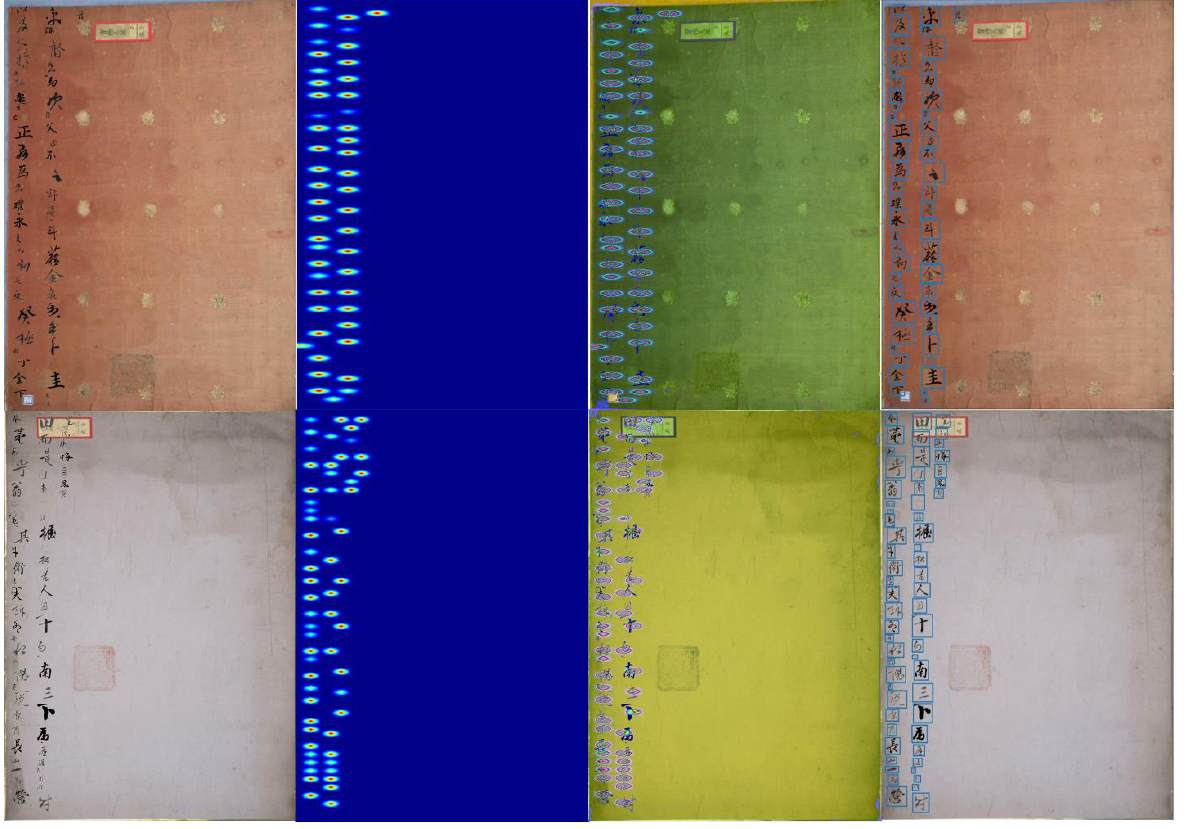
Figure 10. Visual results of a Gaussian heatmap. The first column is the input image, the second column is the Gaussian heatmap, the third column is the characters overlaid on the Gaussian heatmaps, and the last column is the predicted bounding boxes. Table 5. The FC-MSCCD model beat other SOTA models on our benchmark dataset in terms of multi-scale detection and even with different scales in the sub-dataset.